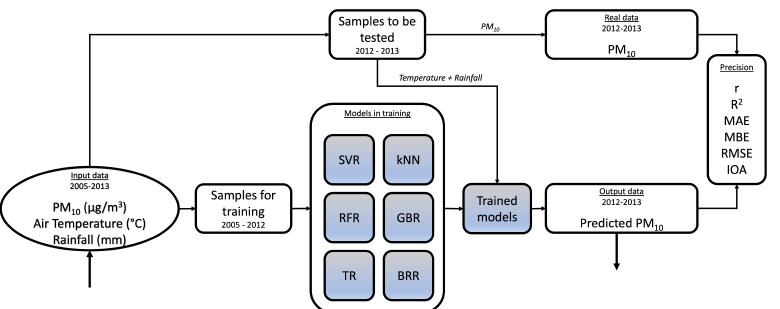
Figure 2. A flowchart describing the methodology performed to apply and validate the machine learning models.